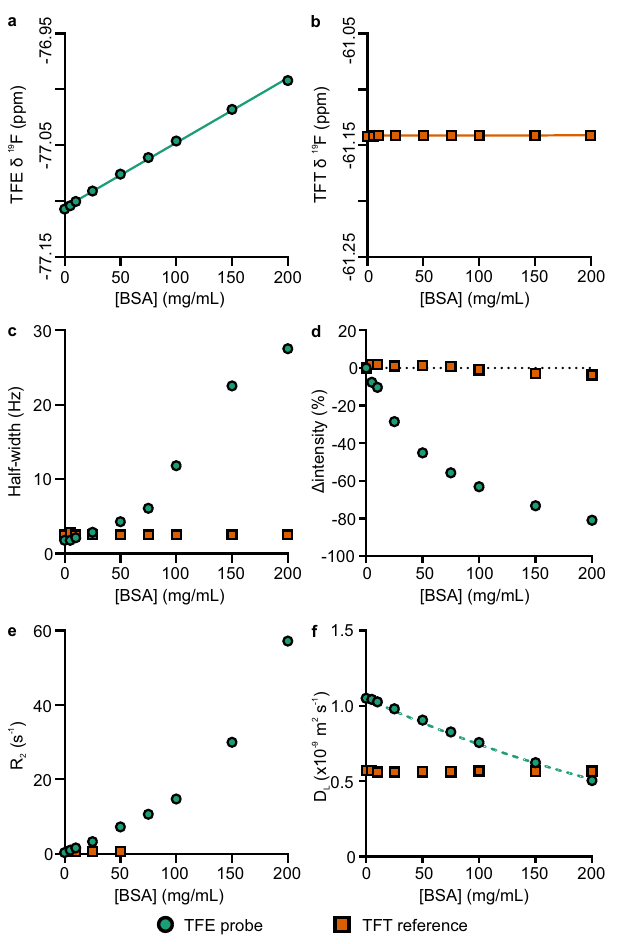
Fig. 1 Effect of protein concentration on TFE probe and TFT reference NMR signal parameters. a TFE and b TFT chemical shift with increasing protein concentration, with linear fi ts plotted. c TFE and TFT linewidth. d Change in probe and reference intensities (normalised against intensity in the absence of BSA). Dotted guideline indicates zero level with no change. e , f Changes in transverse relaxation ( R 2 ) and translational diffusion coef fi cients ( D L ), respectively. The dotted guideline in f indicates the expected reduction in D L as a consequence of increased molecular crowding (Eq. (6)). NMR experiments recorded at 25 °C. For R 2 and D L the fi tting errors (95% con fi dence intervals estimated using the Monte Carlo approach) are generally smaller than the symbols used. Source data are provided as a Source Data fi le.